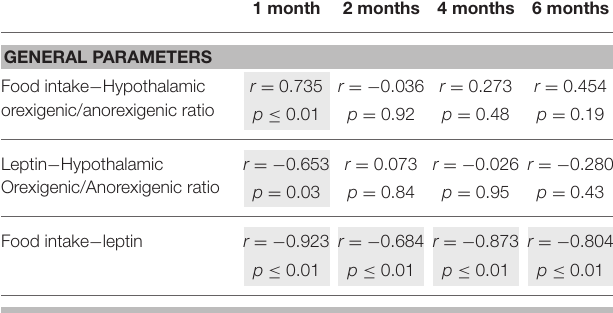
TABLE 3 | Correlation